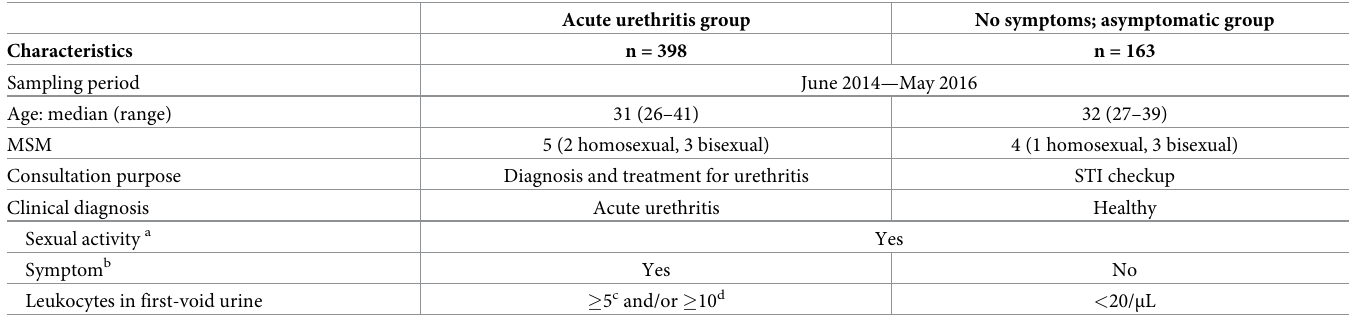
Table 1. Patient